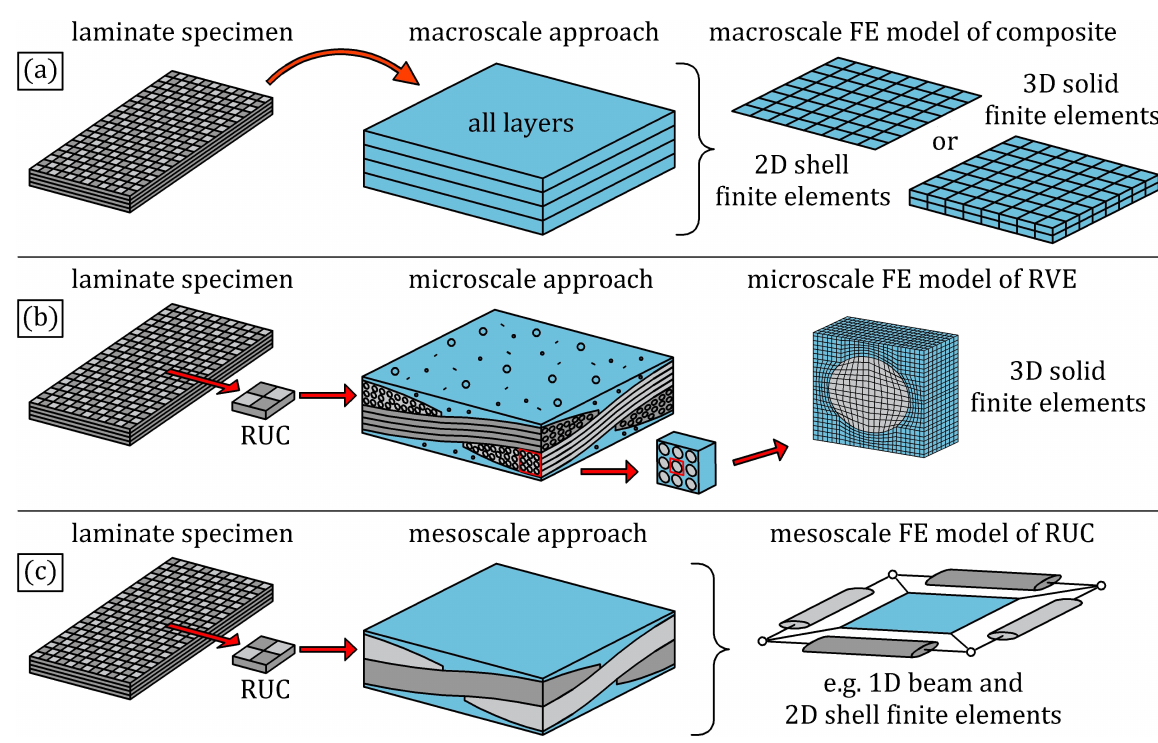
Figure 1: Levels of modeling of layered composite. (a) macroscale level, (b) microscale level, (c) mesoscale level.